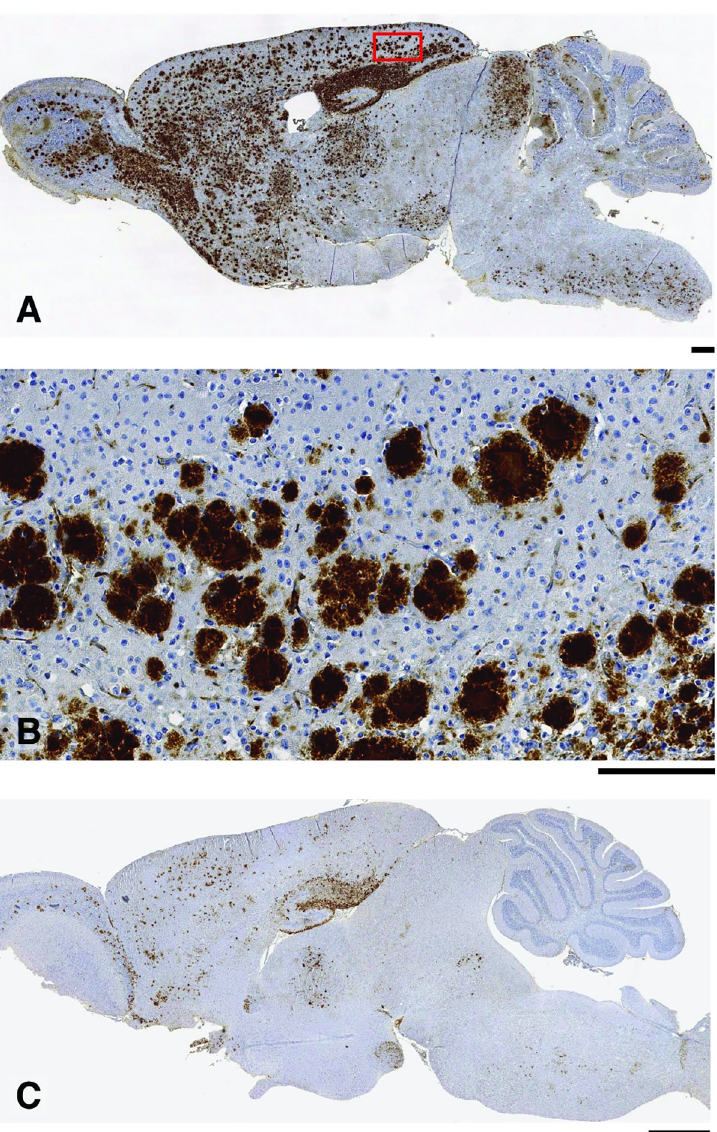
Fig 3. Immunohistochemical analyses of brain from 117VV Tg30 mice challenged with a spontaneous 117V prion isolate. (A, B) Primary transmission of spontaneous 117V prion isolate (from 117V Spont-A mouse brain) to 117VV Tg30 mice. Brain from challenged mice was examined by IHC using anti-PrP monoclonal antibody ICSM 35. (A) Sagittal brain section from a mouse culled at 733 days post-inoculation with neurological disease showing widespread PrP deposition. (B) Magnification of the midsection of the same brain shown in panel A showing detailed granular nature of the PrP plaques. (C) Sagittal brain section from an uninoculated 117VV Tg30 mouse (culled at 852 days old without neurological disease; see Fig 1C and S1 Data) showing the maximum intensity of spontaneous PrP deposition that we observed in aged uninoculated 117VV Tg30 mice. Scale bars: panels A and B, 300 μ m; panel C, 1 mm.